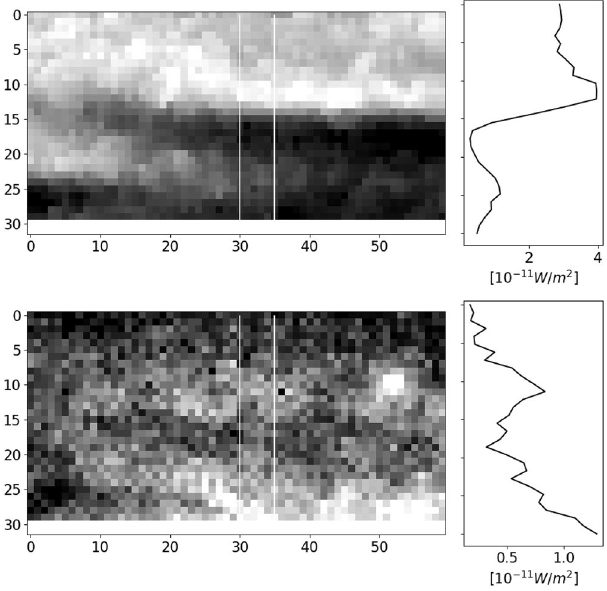
Figure 4. Zoomed image of anti-black/black aurora during 22:56:19–22:56:28 UT (panels t3–t5 of Figs. 2, 3, red squares in panel t4 show sampled location) for 427.8 (upper panel) and 844.6 nm (lower panel) with their respective calibrated brightness profiles (right-hand column) averaged between the solid white lines. The axes represent pixel coordinates.